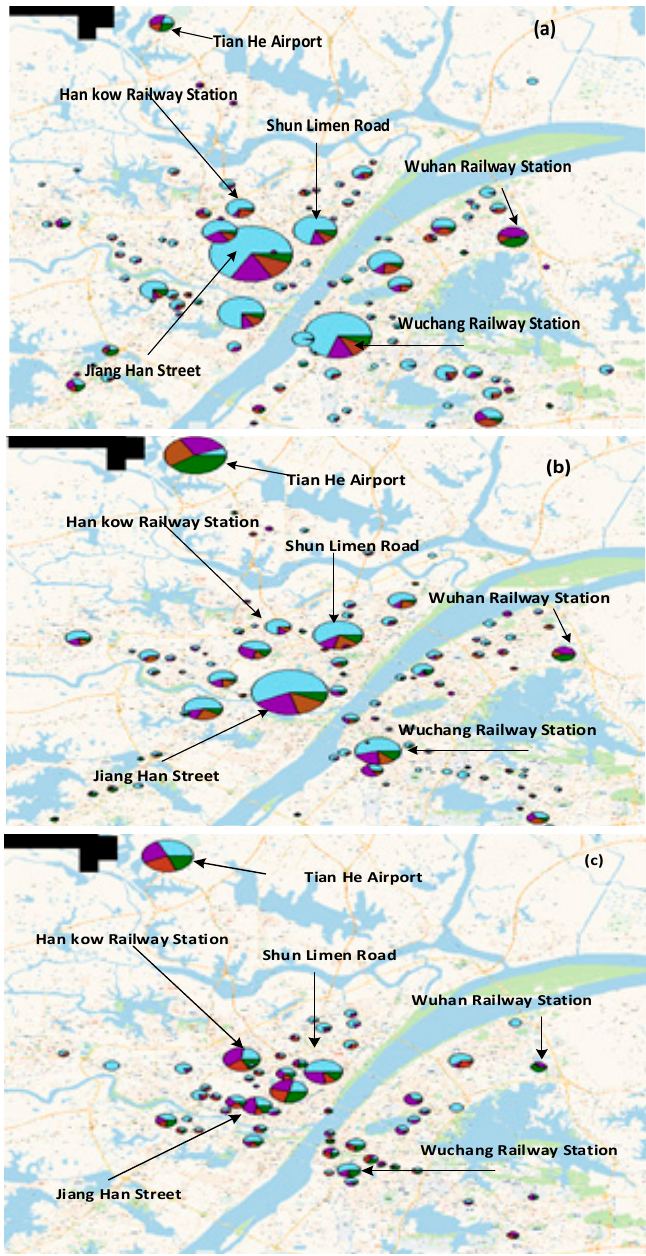
Figure 8. Spatial and temporal patterns of stopping spots of high ( a ), moderate ( b ) and low ( c ) profitability drivers for longer durations.